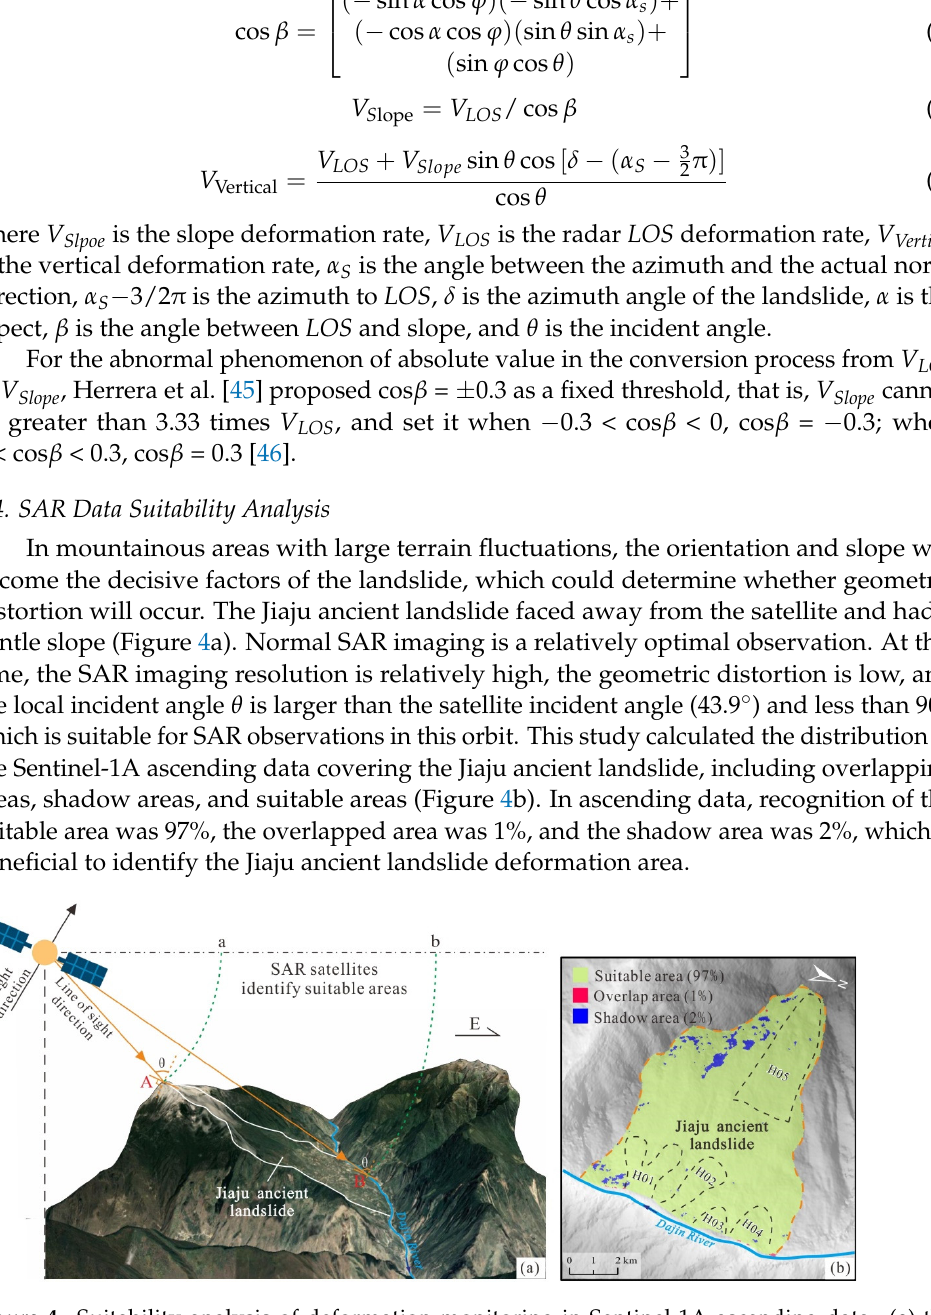
Figure 4. Suitability analysis of deformation monitoring in Sentinel ‐ 1A ascending data. ( a ) the principle of SAR side ‐ view imaging in the Jiaju ancient landslide; ( b ) geometric distortions of Sen ‐ tinel ⁃ 1 ascending image along the Jiaju ancient landslide. principle of SAR side-view imaging in the Jiaju ancient landslide; ( b ) geometric distortions of Sentinel-1 ascending image along the Jiaju ancient